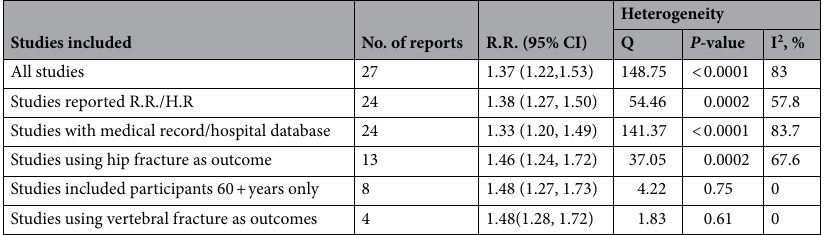
Table 2. Risk of fracture associated with smoking in studies with different inclusion criteria. The frequentist approach and random-effect model were used for analysis unless noted otherwise.